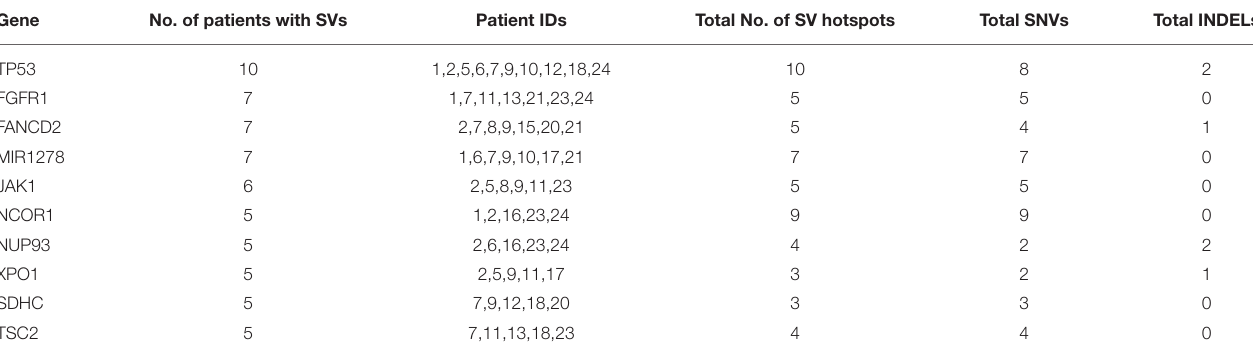
TABLE 6 | Summary of recurrent genes exhibiting somatic mutations in at least 25% of liver cancer patients. Gene No. of patients with SVs Patient